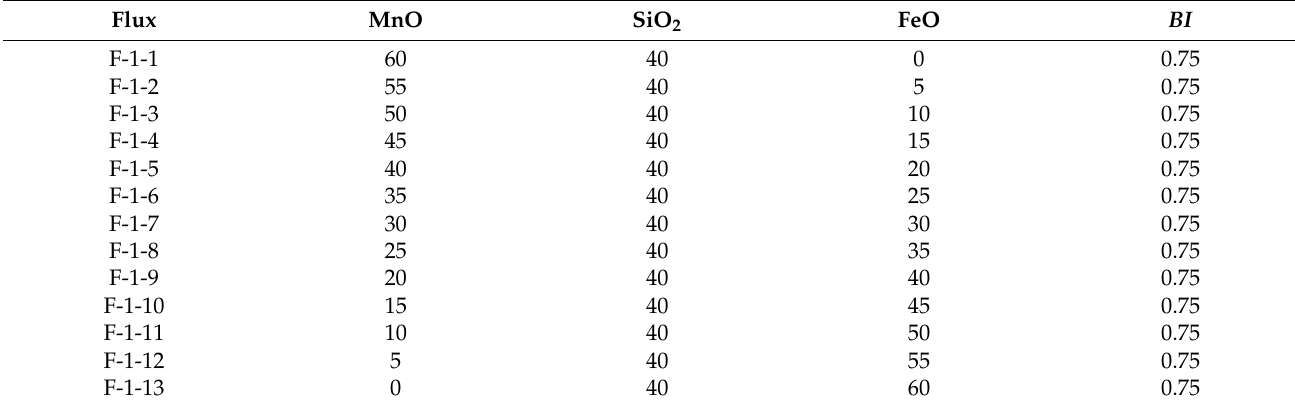
Table 1. Flux formulas subject to SiO 2 -MnO-FeO fluxes [17].